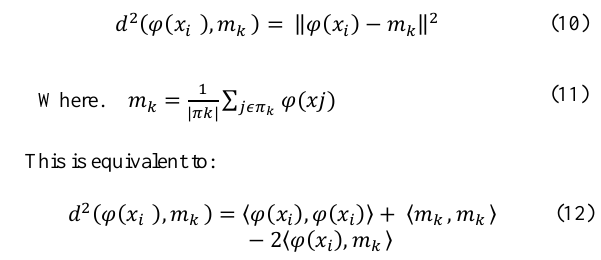
Fig. 3. Pauli images of dataset, (a) Region2 in 2014, (b) Region 2 in 2019, (c) ground truth Region 2.